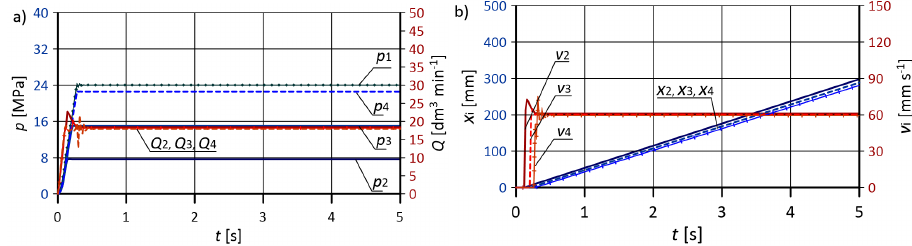
Figure 13. Results of the LSB system with variable load: F load ,2 = 37.5 kN, F load ,3 = 75 kN, F load ,4 = 112.5 kN and the required piston speed v i = 60.0 mm/s; ( a ) pressures and flow rates, ( b ) speeds and positions of actuators.